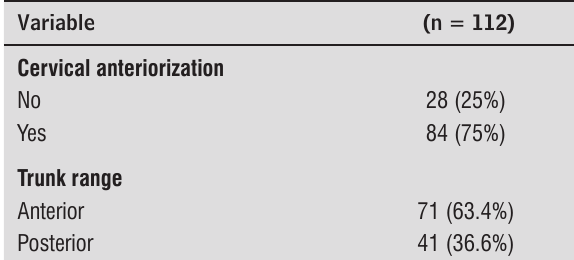
Table 2 - Range trunk and change in cervical posture mea-